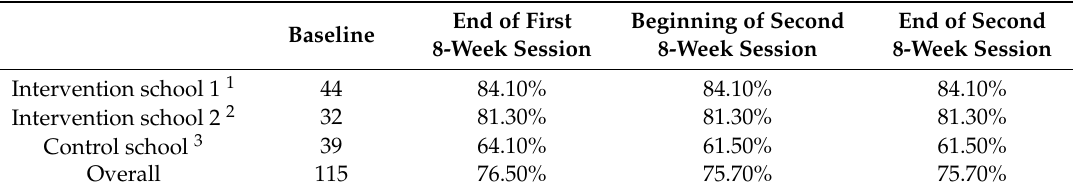
Table 2. Participant Retention